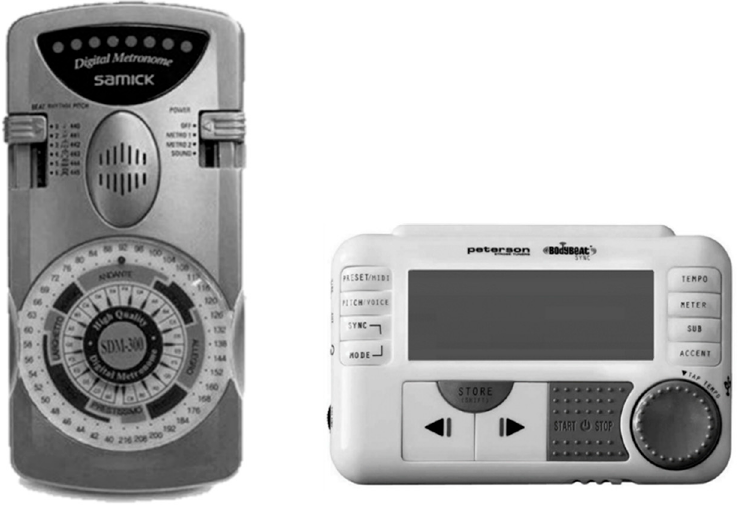
Figure 4. Both the SDM300 SAMICK and Peterson BodyBeat Pulsing Metronome provide features such as tempo, tone and volume adjustments, a built-in speaker and a headphone jack.